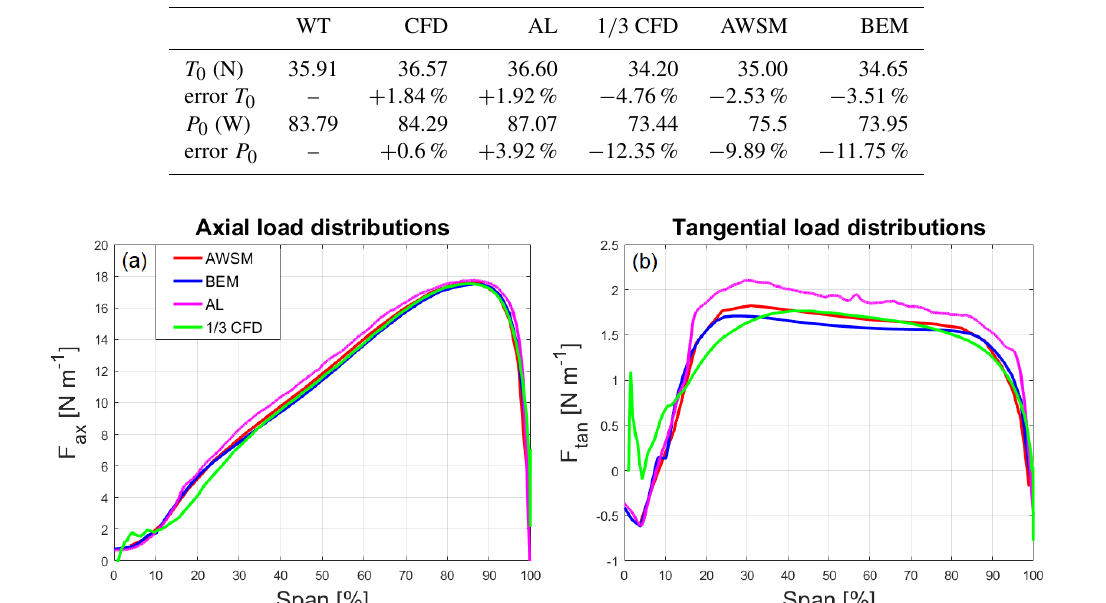
Figure 6. Axial and tangential spanwise load distribution comparison.